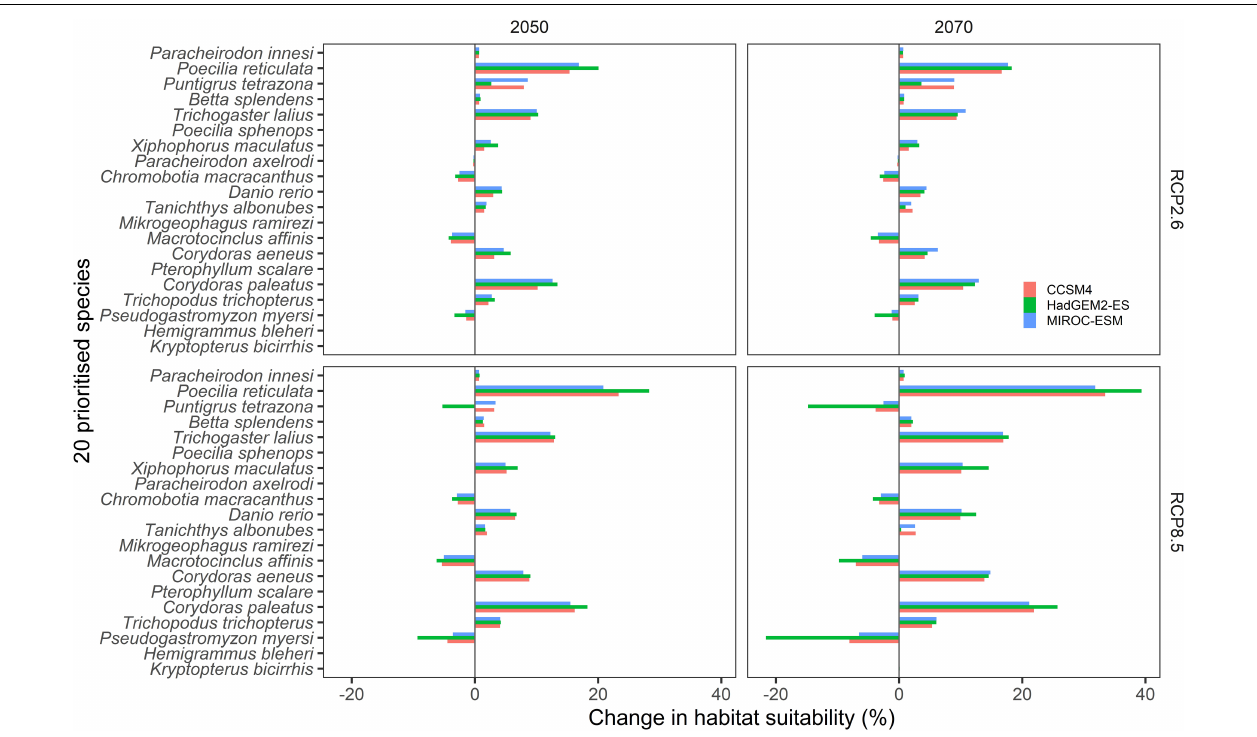
FIGURE 7 | Predicted changes in habitat suitability for the 20 prioritized aquatic ornamental species imported to New Zealand under future (2050 and 2070) climate scenarios (RCP2.6 and RCP8.5) relative to current habitat suitability as predicted by the MaxEnt species distribution models (see Figure 3